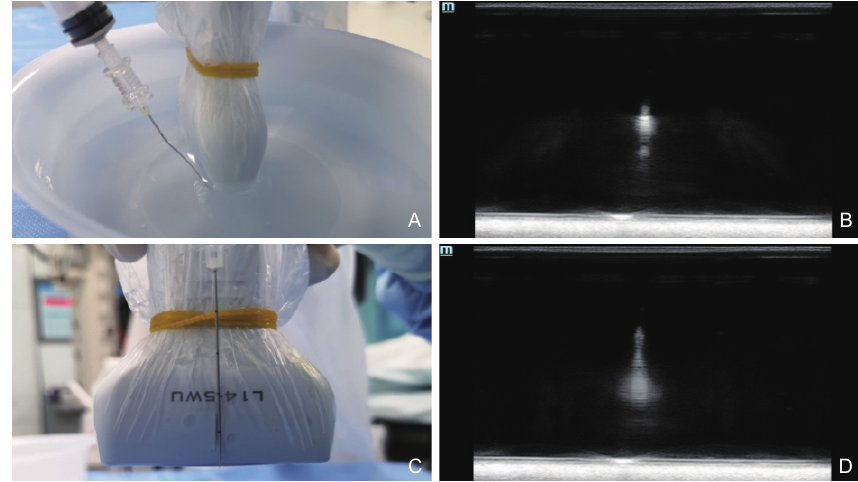
Figure 13 Probe’s side approach. (A) Probe’s side approach at a large angle; (B) The strong echo on the image cannot be sure that it is the reflection of the puncture needle tip; (C) Probe’s side approach at a small angle; (D) The strong echo on the image cannot be sure that it is the reflection of the puncture needle shaft.